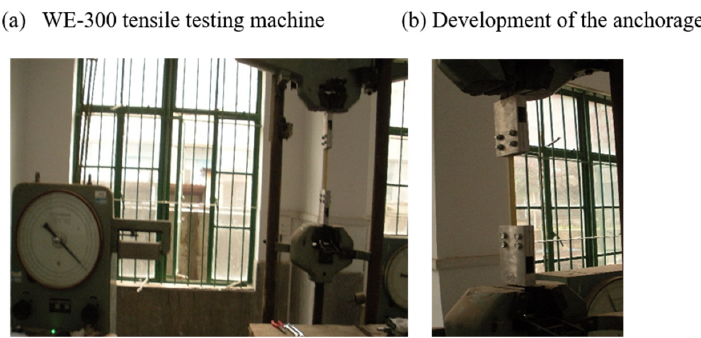
Figure 2. The photos of tensile testing device.